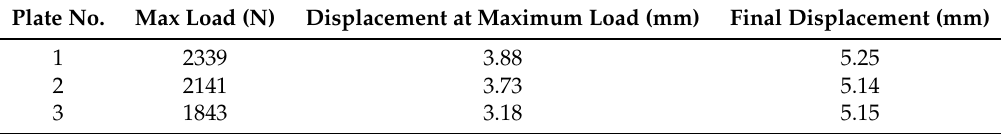
Table 2. Indentation test on jute/hemp fiber hybrid